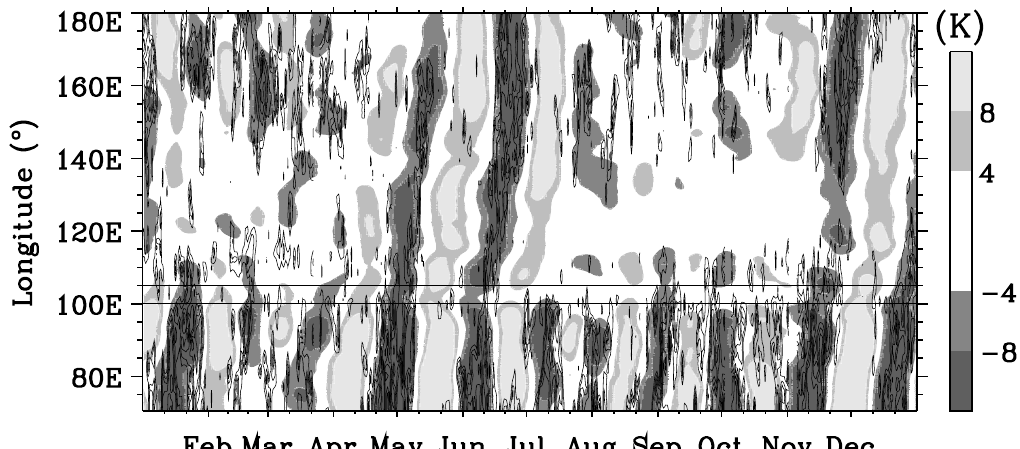
Fig. 2. Time-longitude plot of bandpass-filtered T BB with cutoffs at 25 days and 60 days (shaded) and daily-averaged T BB (solid) averaged over 2 . 5 ◦ S–2 . 5 ◦ N in 2002. Solid contours begin at 260 K, and decrease with the interval of 10K. The horizontal solid line shows the longitude of 100 ◦ E and 105 ◦